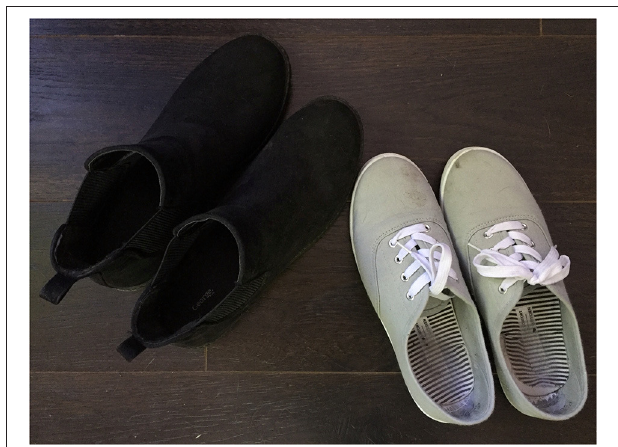
FIGURE 3 | Together : What helps us feel better about the challenges of having a parent with a mental disorder is social support. It allows us to confide in each other during difficult times, to share our happiness and to dream together. My girlfriend and some of my friends offer me a lot of support in my daily life.